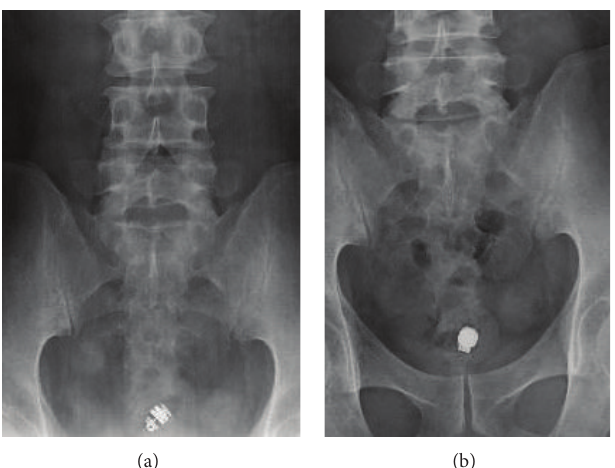
Figure 1: Abdominal X-ray image visualizing a CE capsule in the pelvic cavity. The capsule retention might have been overlooked if the range of the X-ray image had shifted slightly (a). Follow-up X-ray after 7 days revealed that the capsule remained at the same place (b).